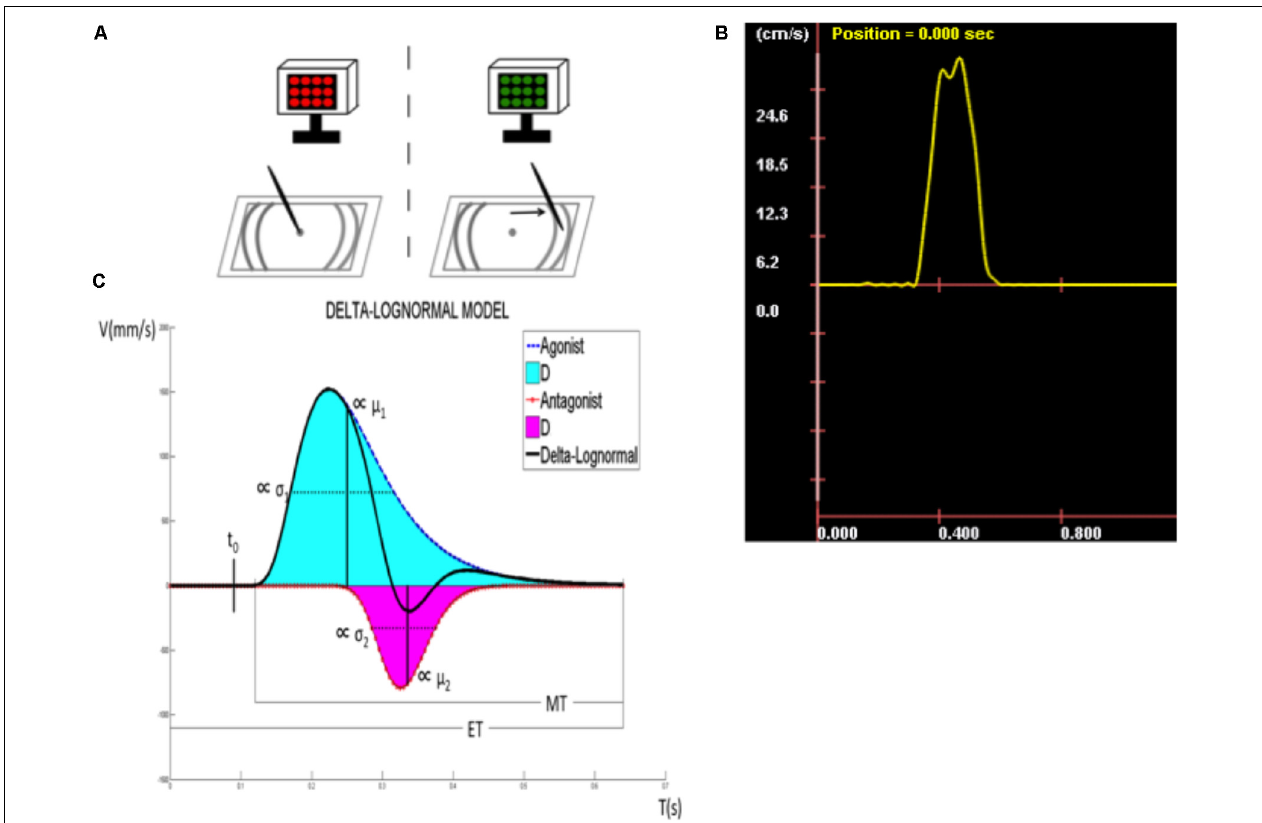
FIGURE 1 | Description of the target directed fast simple RT task. (A) Tablet display and target zone. (B) Speed curve obtained for each line drawn. (C) Kinematic parameters ( t 0 , time occurrence of the input commands to the neuromuscular system; D 1 , agonist component; µ 1 , time delay of D 1 ; σ 1 , response spread of D 1 ; D 2 , antagonist component; µ 2 , time delay of D 2 ; σ 2 , response spread of D 2 ; ET, time between visual stimulus and the immobilization of the stylus; RT, reaction time; MT, movement